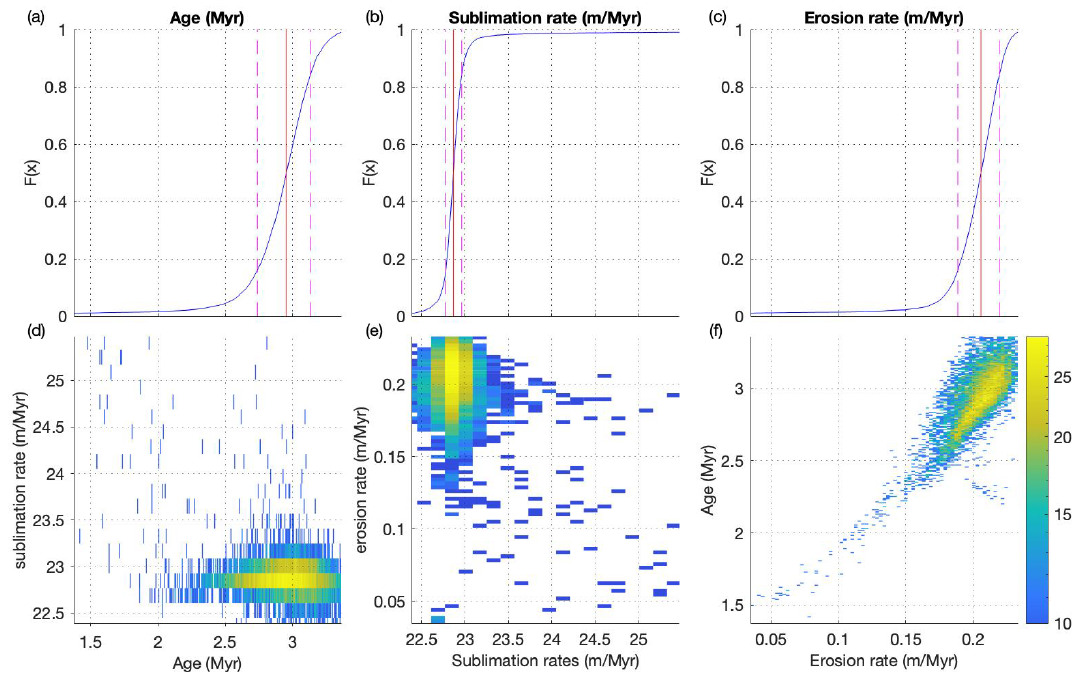
Figure 8. (a–c) Cumulative distribution of 10000 fitted Monte Carlo simulation results showing the 50th percentile (red line) with error bounds given by the 16th and 84th (pink lines). (f–e) Density plot as paired distribution of Monte Carlo simulation results separated into 1000 bins with yellow being high density and blue low density. Both the vertical and horizontal axes (d–f) are truncated to the 98% (0.01 and 0.99) confidence